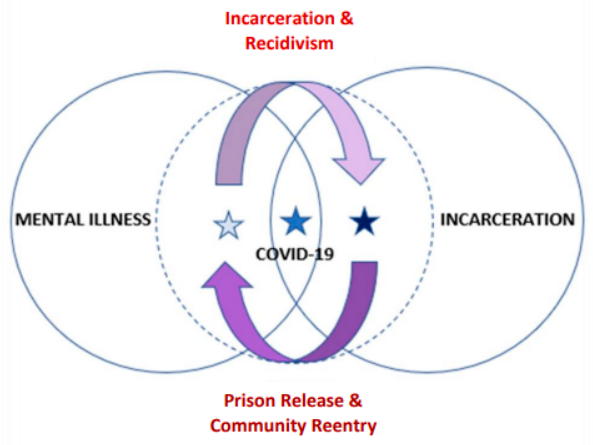
Figure 1. Logic of the literature sample: Intersections #1–3.